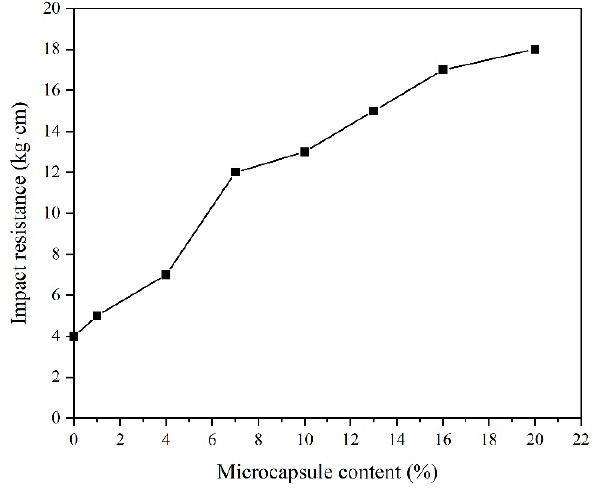
Figure 10. Impact resistance of